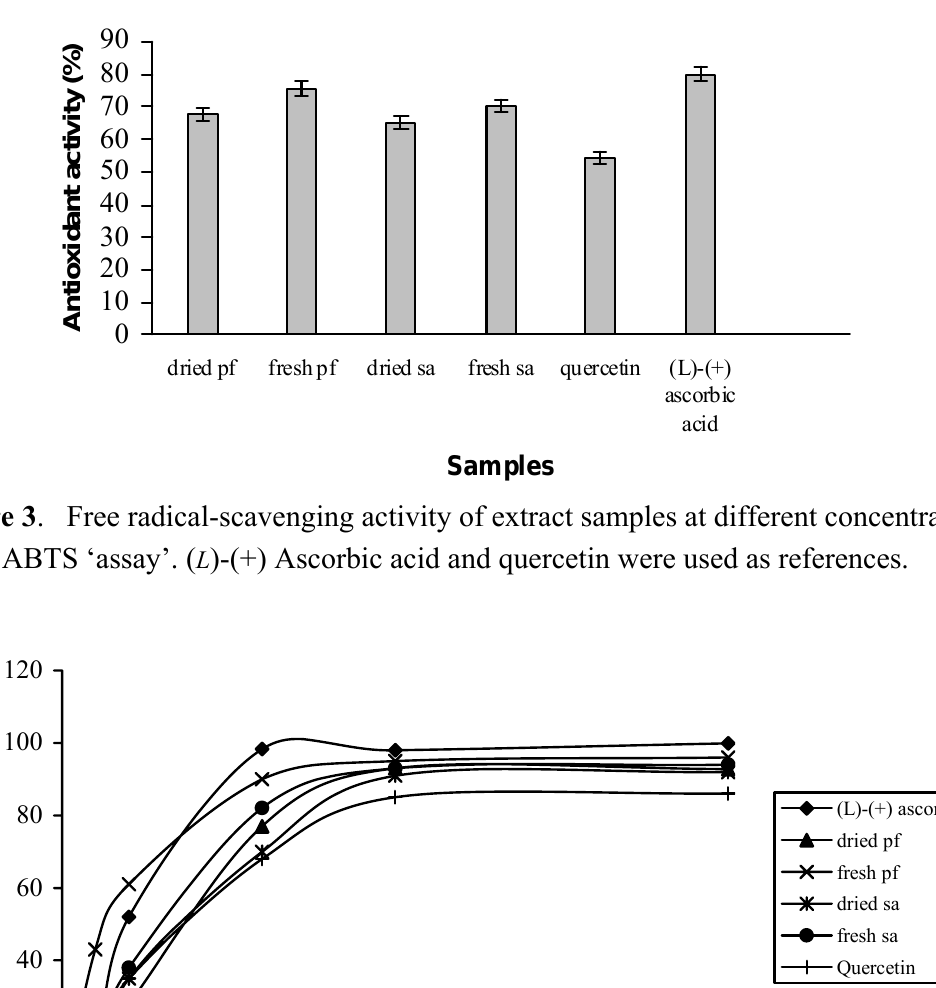
Figure 2 . Values of free radical-scavenging activity of sample extracts in ABTS assay. Variations were significant at level p<0.05.